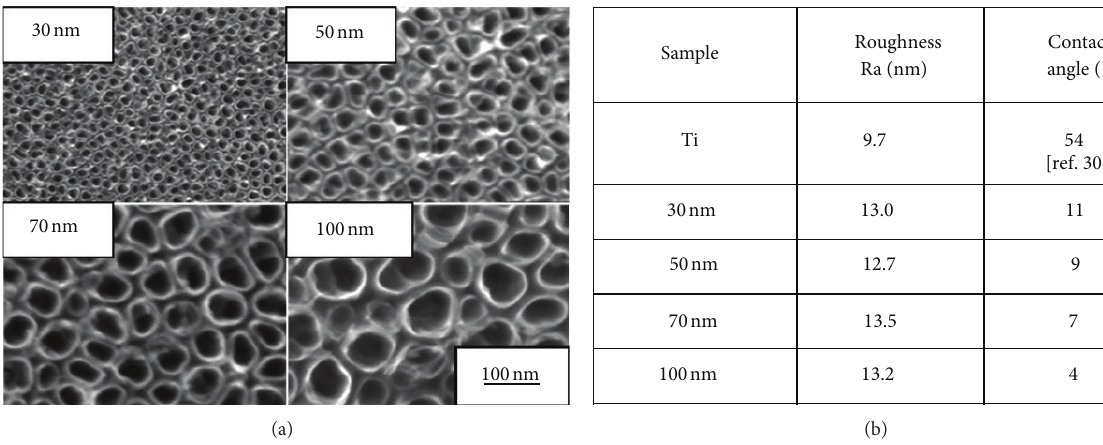
Figure 2: Physical characterization of different-sized nanotube surfaces. (a) SEM micrographs of self-aligned TiO 2 nanotubes with different diameters. The images show highly ordered nanotubes with four different pore sizes between 30–100nm. (b) Table with average roughness ( 𝑅 𝑎 ) and surface contact angle measurements for Ti and 30–100 nm TiO 2 nanotube surfaces.